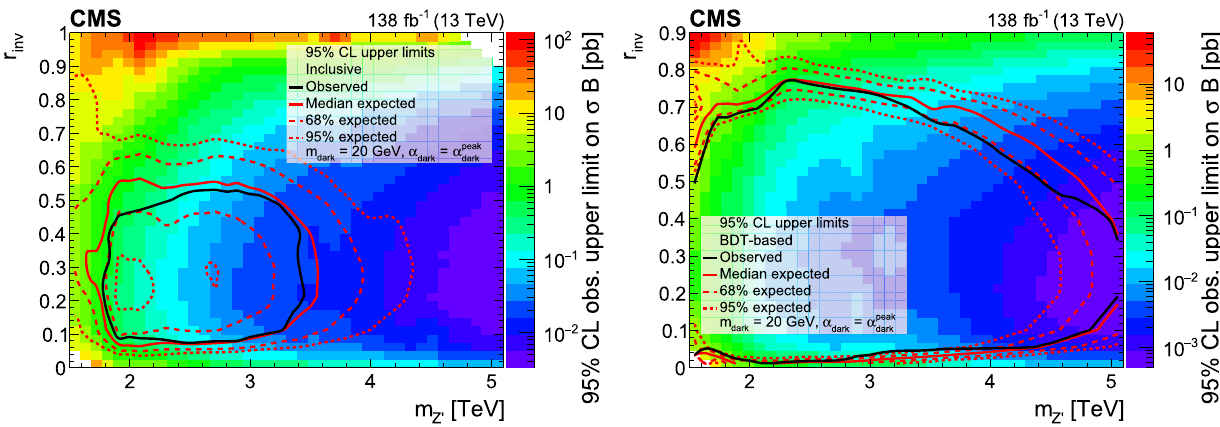
Fig. 10 95% CL limits on the cross section for Z (cid:7) → semi-visible jets in a two-dimensional plane with variations of m Z (cid:7) and r inv from the model-independent (left) and model-dependent (right) searches, where m π α dark ). Reproduced from Ref. [91]